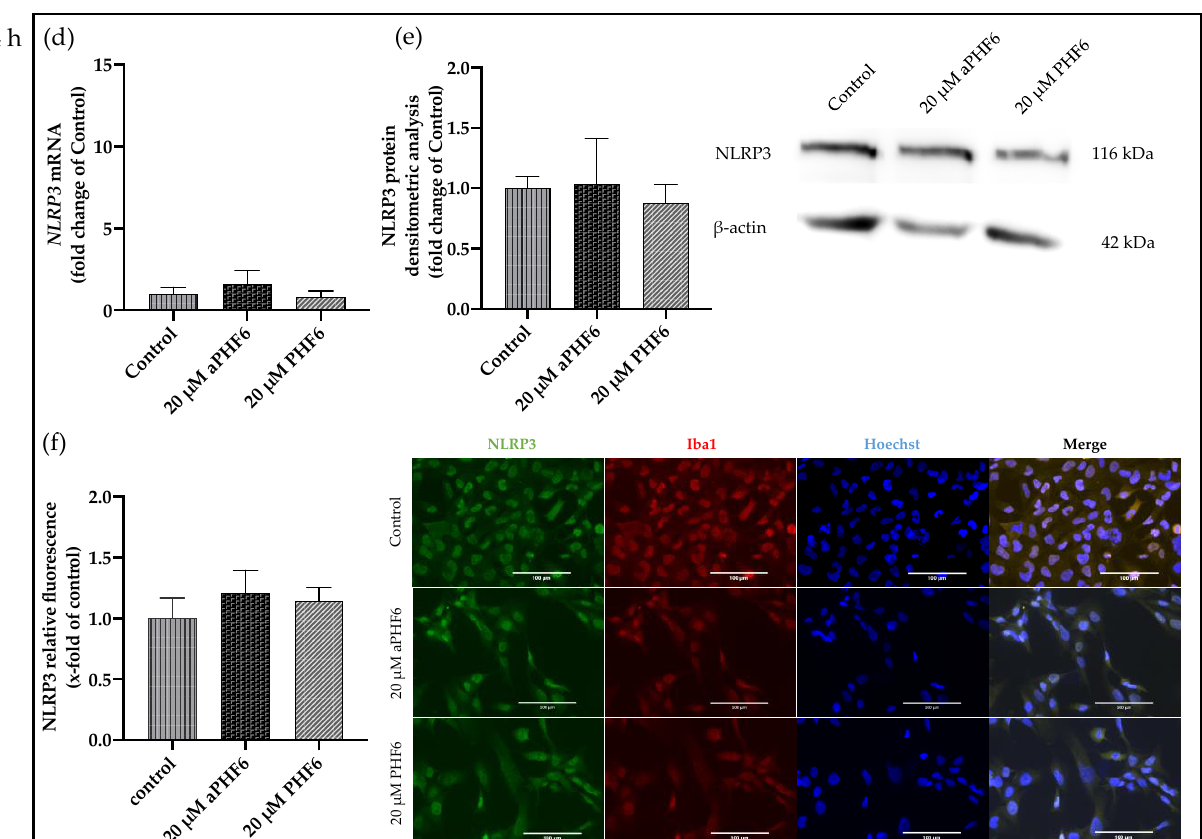
Figure 3. Aggregated PHF6 upregulated NLRP3 mRNA and protein in human microglial cells after 6 h ( a – c ), but the effect is absent after 24 h ( d – f ). ( a ) Treatment with 20 µ M aPHF6 resulted in a seven-fold increase in the NLRP3 mRNA compared to PHF6 or untreated controls as quantified by qRT-PCR. ( b ) NLRP3 Western blots densitometry revealed a 1.5-fold increase in the protein levels of treated cells compared to control after 6 h of stimulation. ( c ) aPHF6 treatment depicted an increased NLRP3 fluorescence intensity (1.5 times) compared to other treatment groups. ( d ) Gene expression analysis revealed no effect of the treatment with 20 µ M aPHF6 on the NLRP3 expression compared to PHF6 or untreated controls. ( e ) Densitometric analysis of NLRP3 Western blots confirmed no significant changes in protein levels at 24 h. ( f ) However, in some cells an increased NLRP3 fluorescence intensity is observed after the aPHF6 treatment. */# p < 0.05; ***/### p <